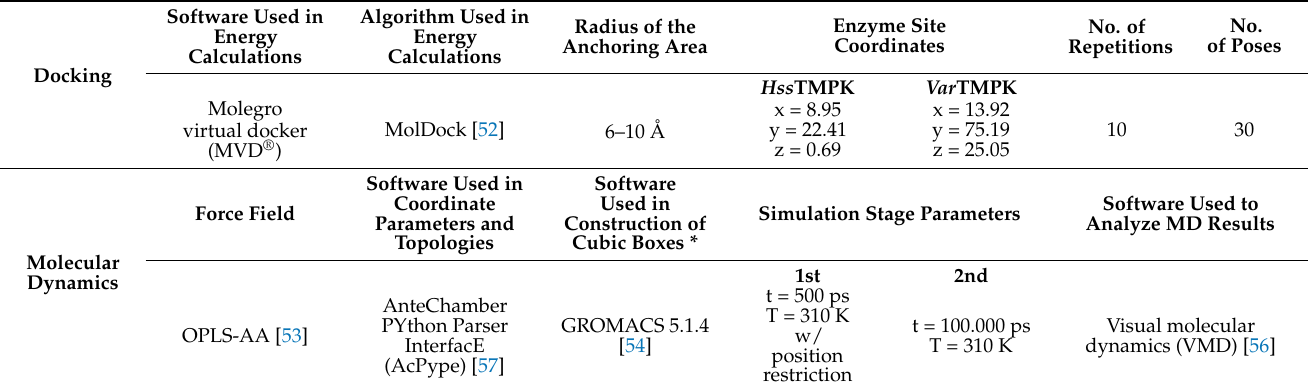
Table 5. Parameters used in the docking and MD